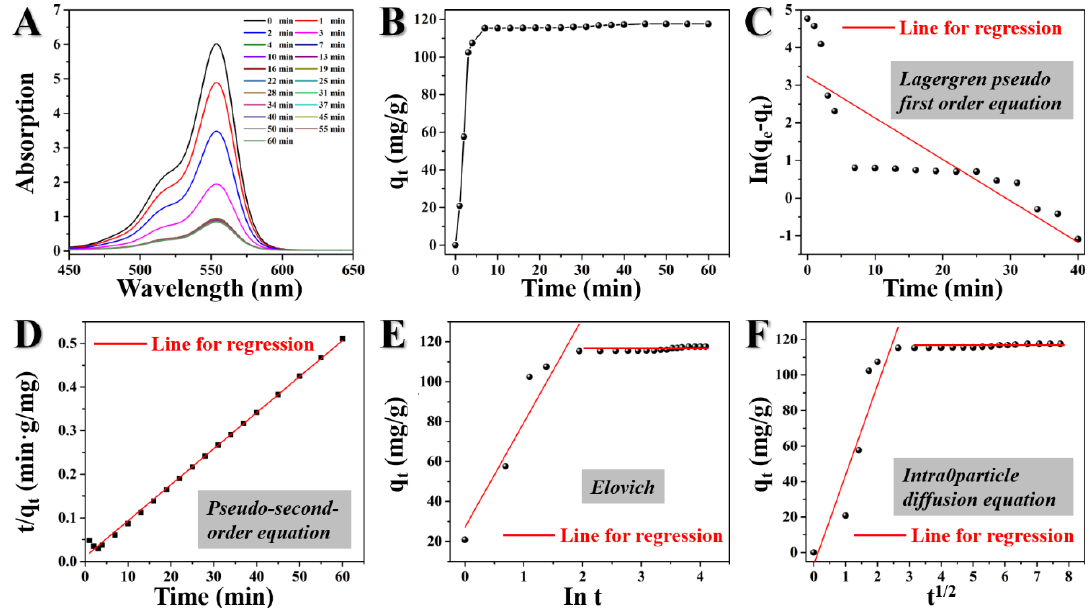
Figure 6. ( A ) Successive UV-vis spectra of the remaining RhB in the solution after being treated with magnetic carbon foam at different time intervals. ( B ) The kinetic data for RhB adsorption by magnetic carbon foam. ( C–F ) Fitting of Lagergren pseudo-first order, pseudo-second order, Elovich, and intra-particle diffusion kinetic models for RhB adsorption on magnetic carbon foam. Table 1. Mathematical equations in RhB adsorption kinetics and kinetic parameters of various models fitted to experimental data.